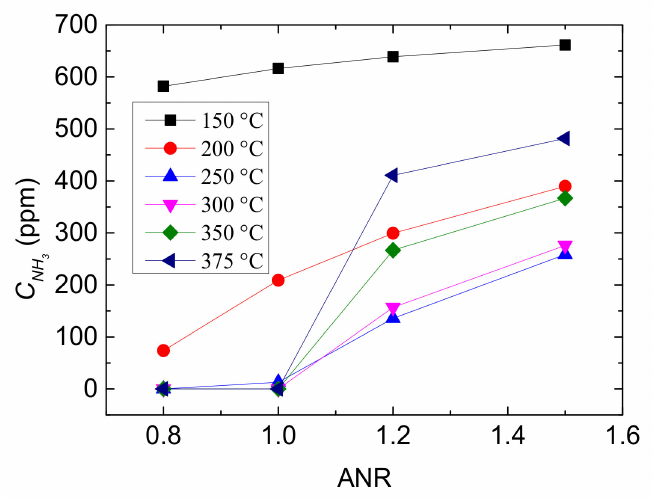
Figure 8. Outlet C NH3 with different values of ANR and reaction